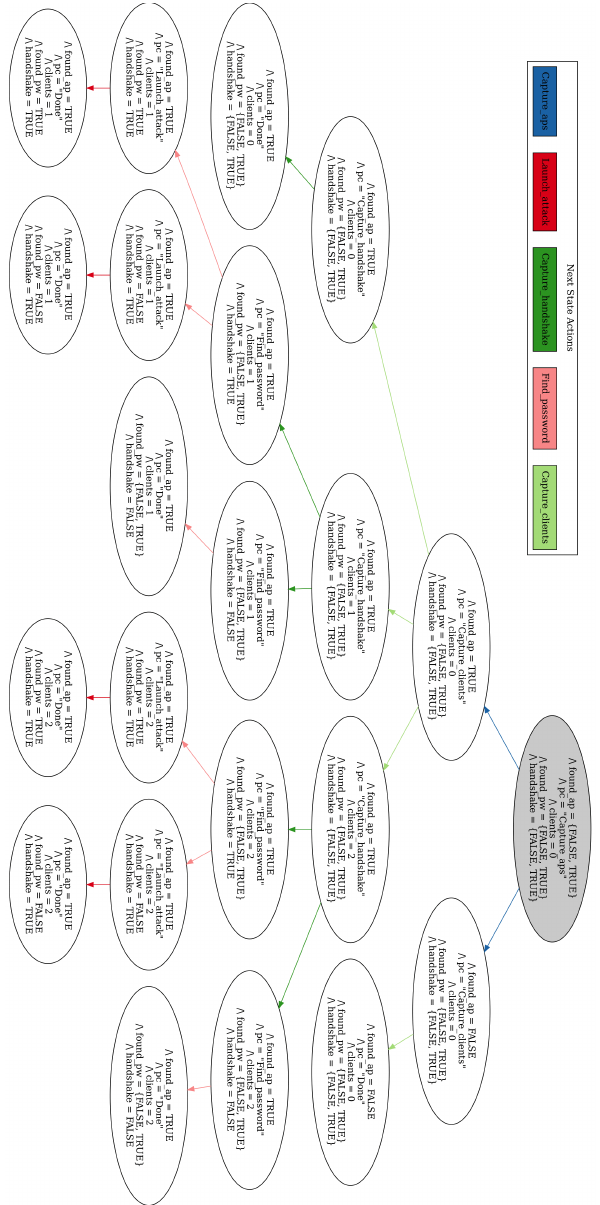
Figure 20. State transition diagram showing all possible states of the Evil Twin attack EP